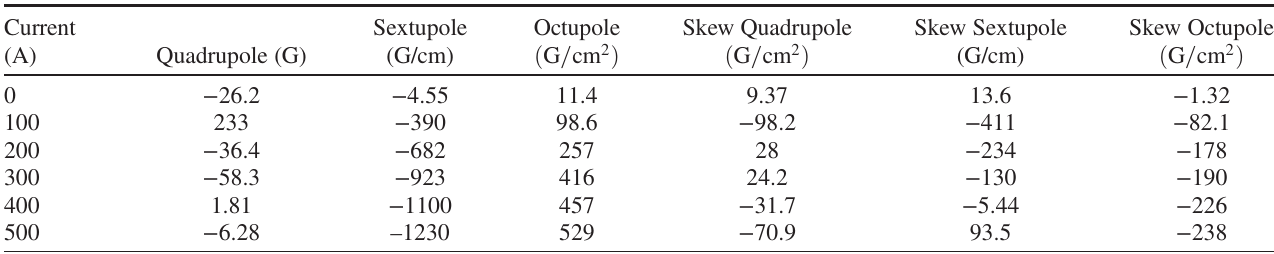
TABLE VII. Measured HSCU multipole components. Current